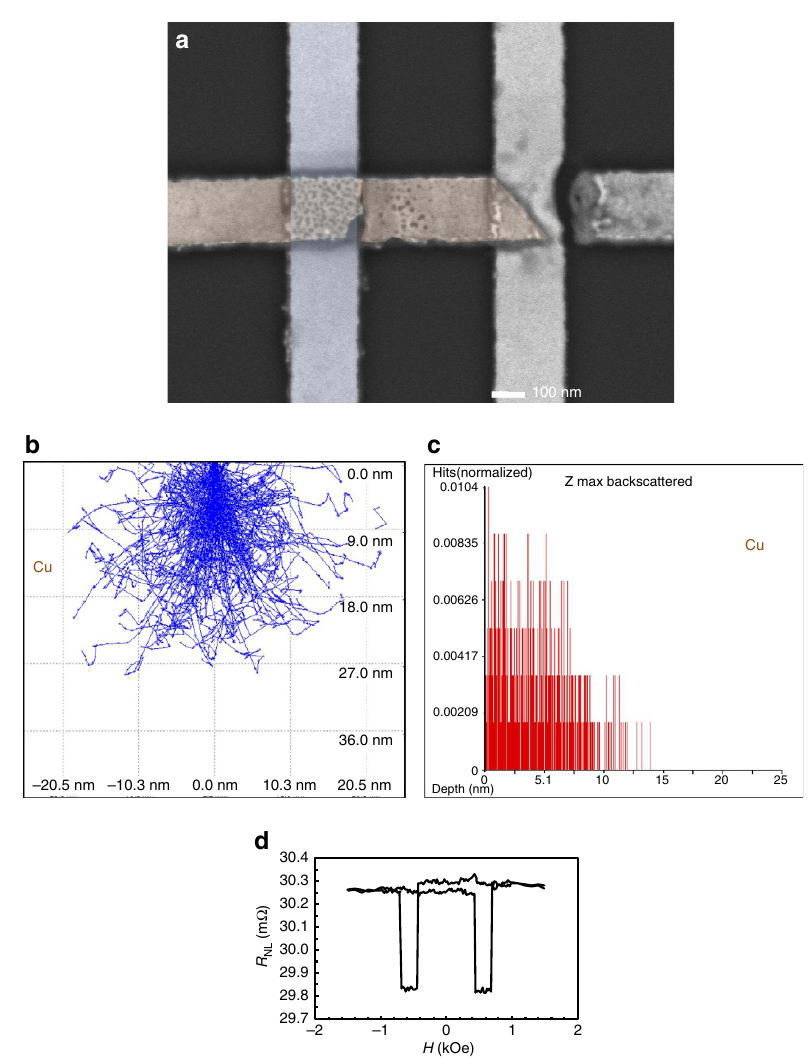
Figure 3 | Imaging of the broken lateral spin–valve with decelerated electron beam. ( a ) Scanning electron microscopy (SEM) image of broken Ni 0.8 Fe 0.2 /Cu junctions taken by upper electron detector (UED) with the BSE mode at V acc ¼ 2.5keV using energy filter above (cid:2) 500V. ( b ) Interaction volume simulations to estimate the penetration depth for a . ( c ) Simulation of the generated backscattered electrons from the Cu layer. ( d ) Magnetoresistance result of the Ni 0.8 Fe 0.2 /Cu junction before the breakdown. NATURE COMMUNICATIONS|7:12701|DOI: